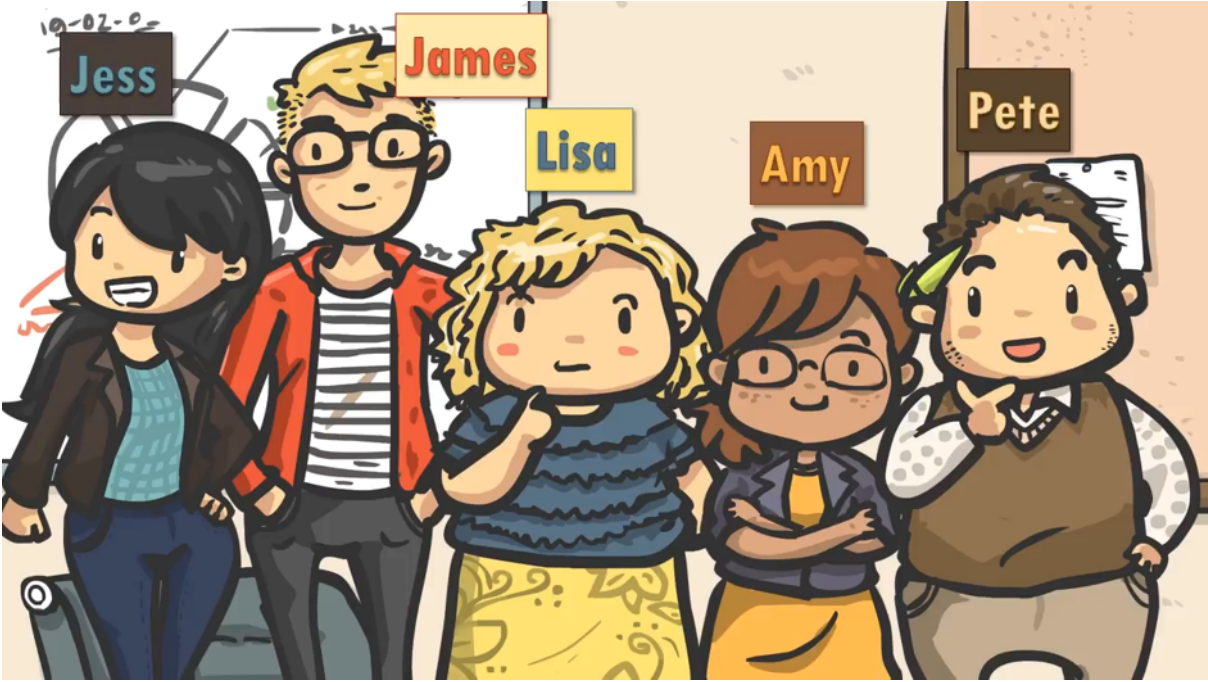
Figure 1. Screenshot of FitMindKit